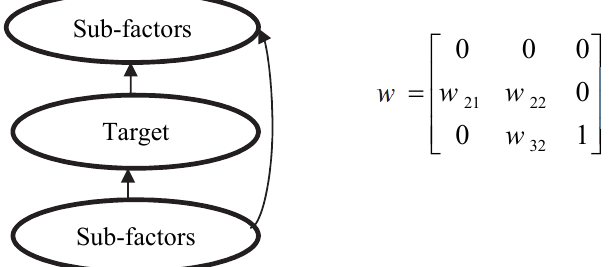
Fig 1. The grid used in this research and its